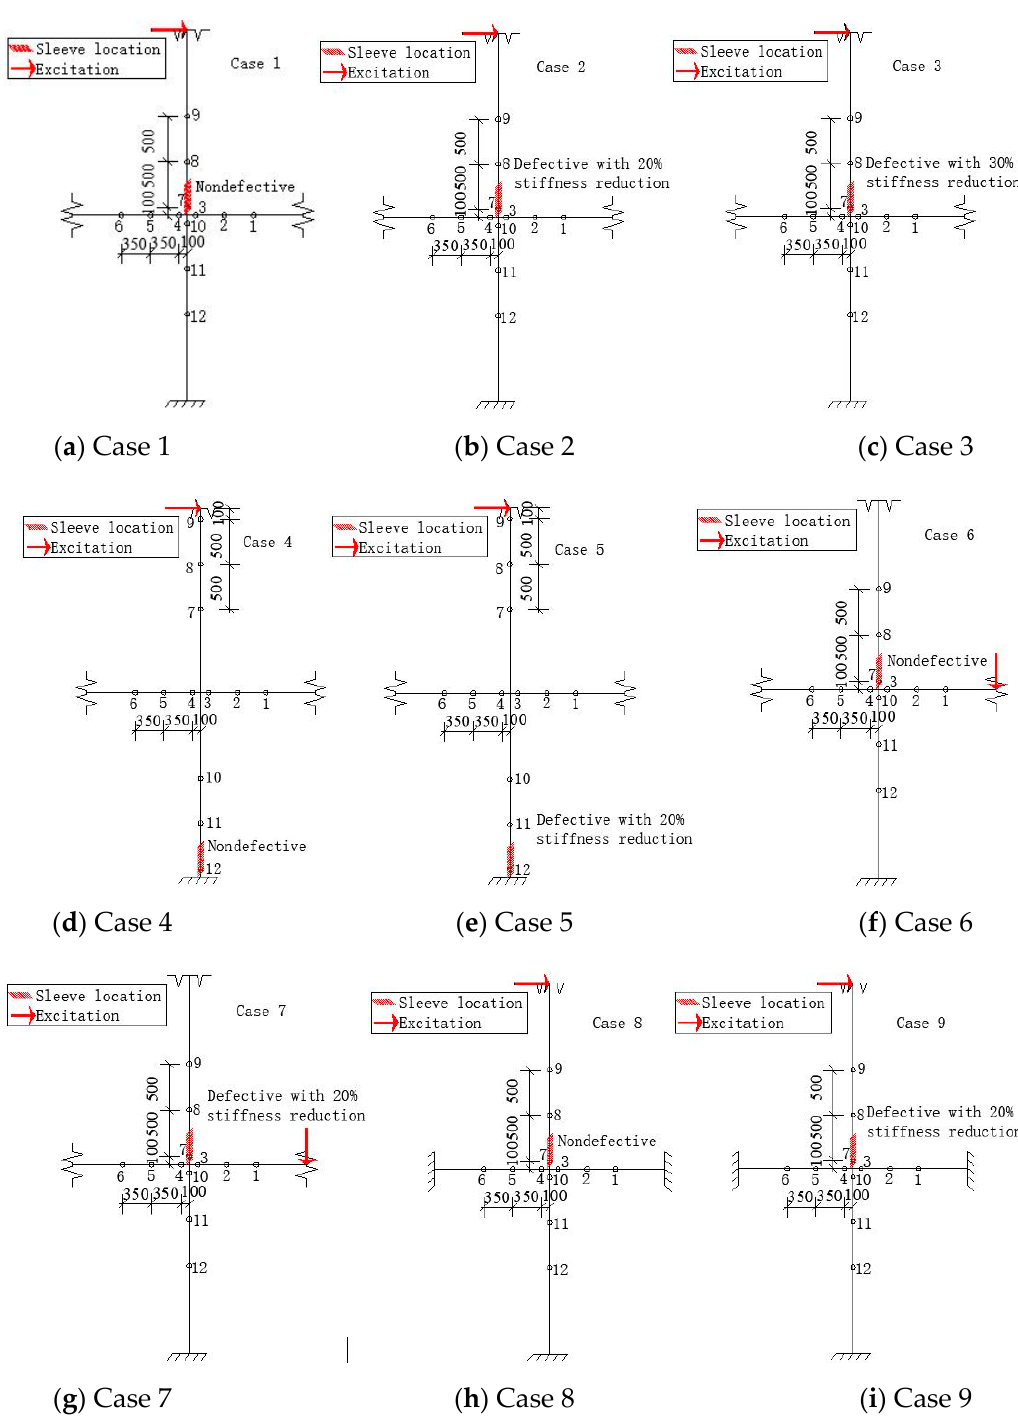
Figure 5. Description of the nine working cases.